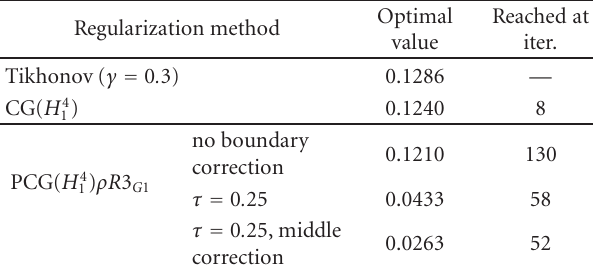
Table 4: Optimal reconstruction error (cid:2) x 2 − (cid:4) x 2 (cid:2) 2 for the 1D blur operator H 4 1 and the original data x 2 . The problem has size n = 10 3 and is a ff ected by random noise of order 0.1%. ρ = 10 2